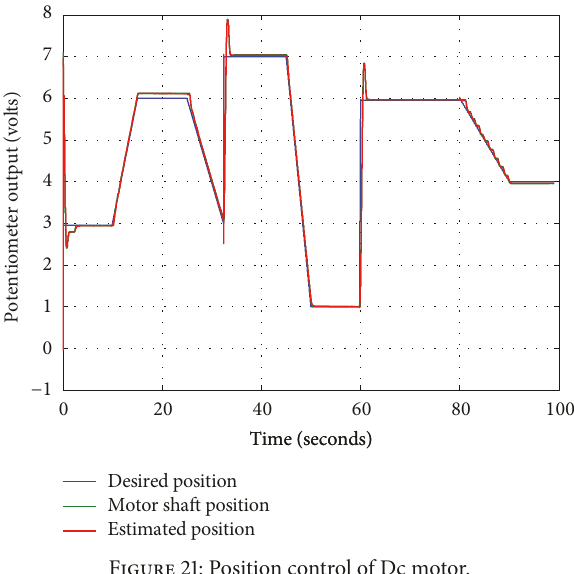
Figure 21: Position control of Dc motor.